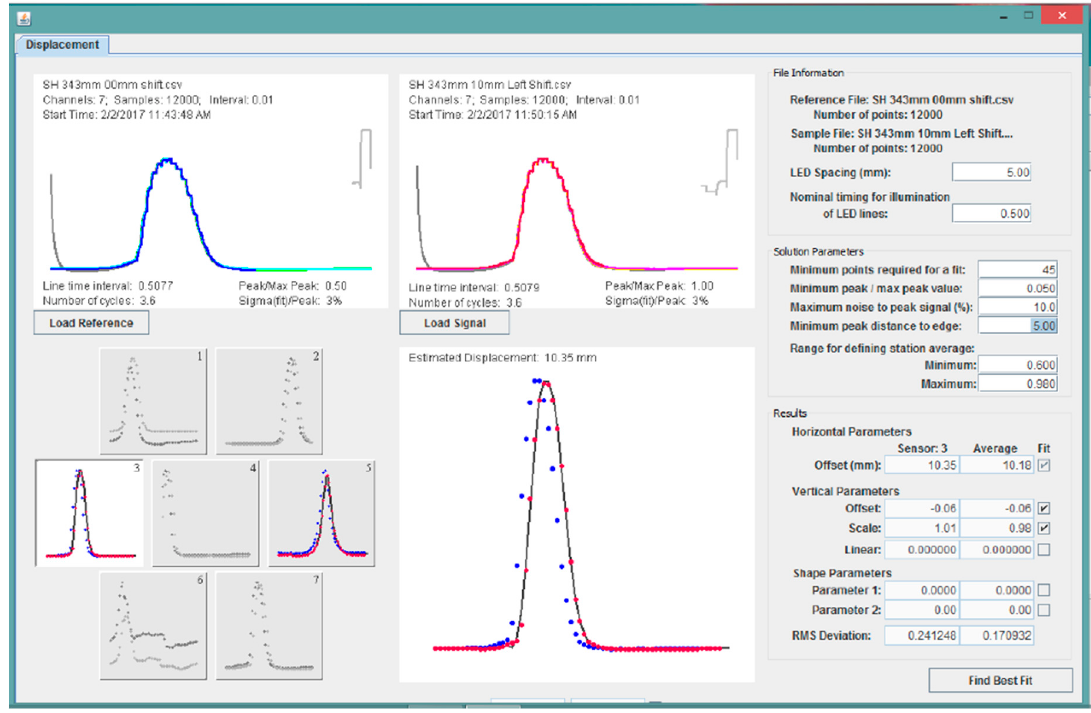
Figure 19. Graphical user interface.